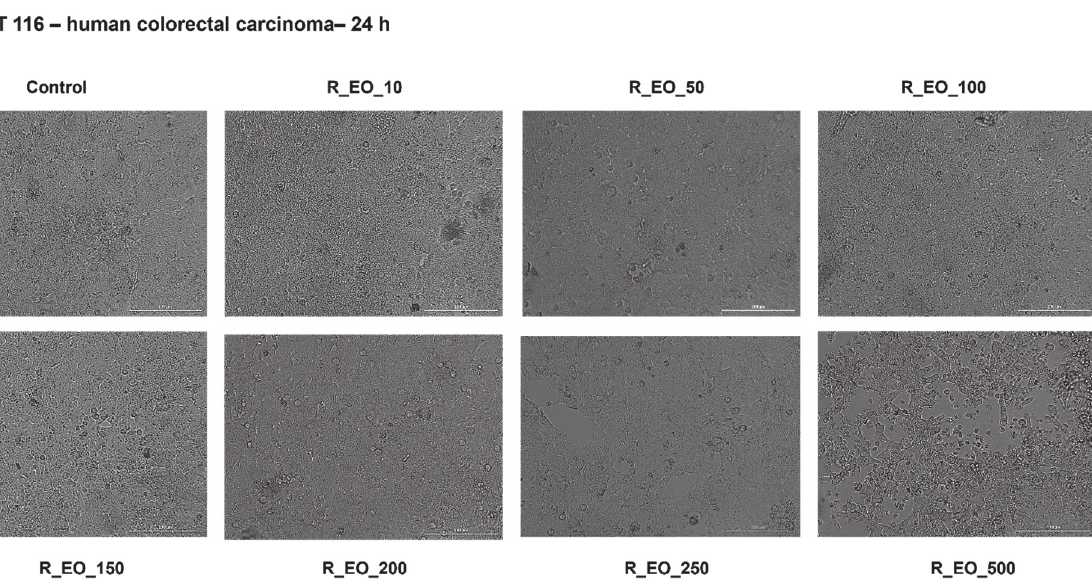
Figure 7. Morphological aspect of HCT 116 cells after treatment for 24 h with Rosmarinus officinalis L. essential oil—R_EO (10, 50, 100, 150, 200, 250 and 500 μ g/mL). The scale bar was 200 μ m.